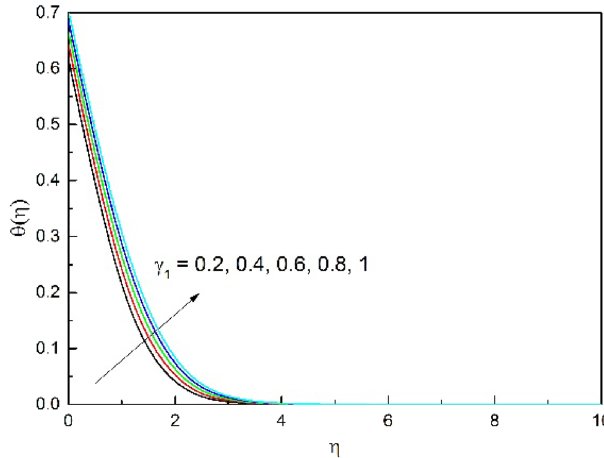
Figure 6. γ 1 on θ(η) .